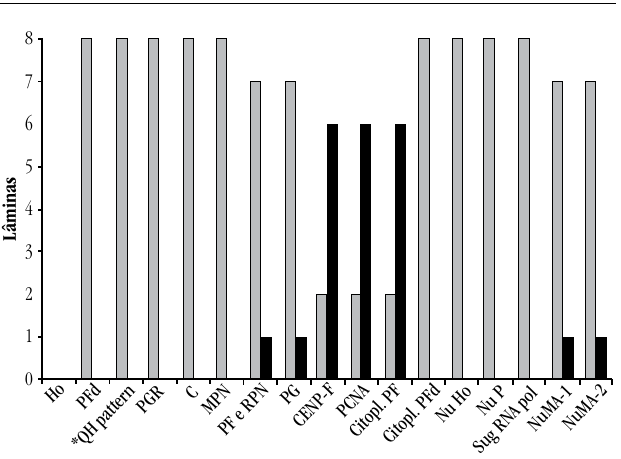
figurE 2 – Characterization ability of 17 autoantibody patterns on HEp-2 cells by eight different slides (seven commercial and one in house) The grey columns indicate the reading concordance within different slides and the black columns suggest inability to identify them. *QH nuclear quasi -homogeneous speckled pattern: center C identified the pattern as dense fine speckled on the first five slides and as homogeneous nuclear in the last three slides. Ho: homogeneous speckled; DFS: dense fine speckled; QH: quasi -homogeneous speckled*; CSTR: coarse speckled type reticulated; C: centromeric; MND: multiple nuclear dots; FS RND: fine speckled and rare nuclear dots; CS: coarse speckled; CENP-F: centromeric protein F; PCNA: proliferating cell nuclear antigen; Cyto FS: fine speckled; Cyto DFS: dense fine speckled;